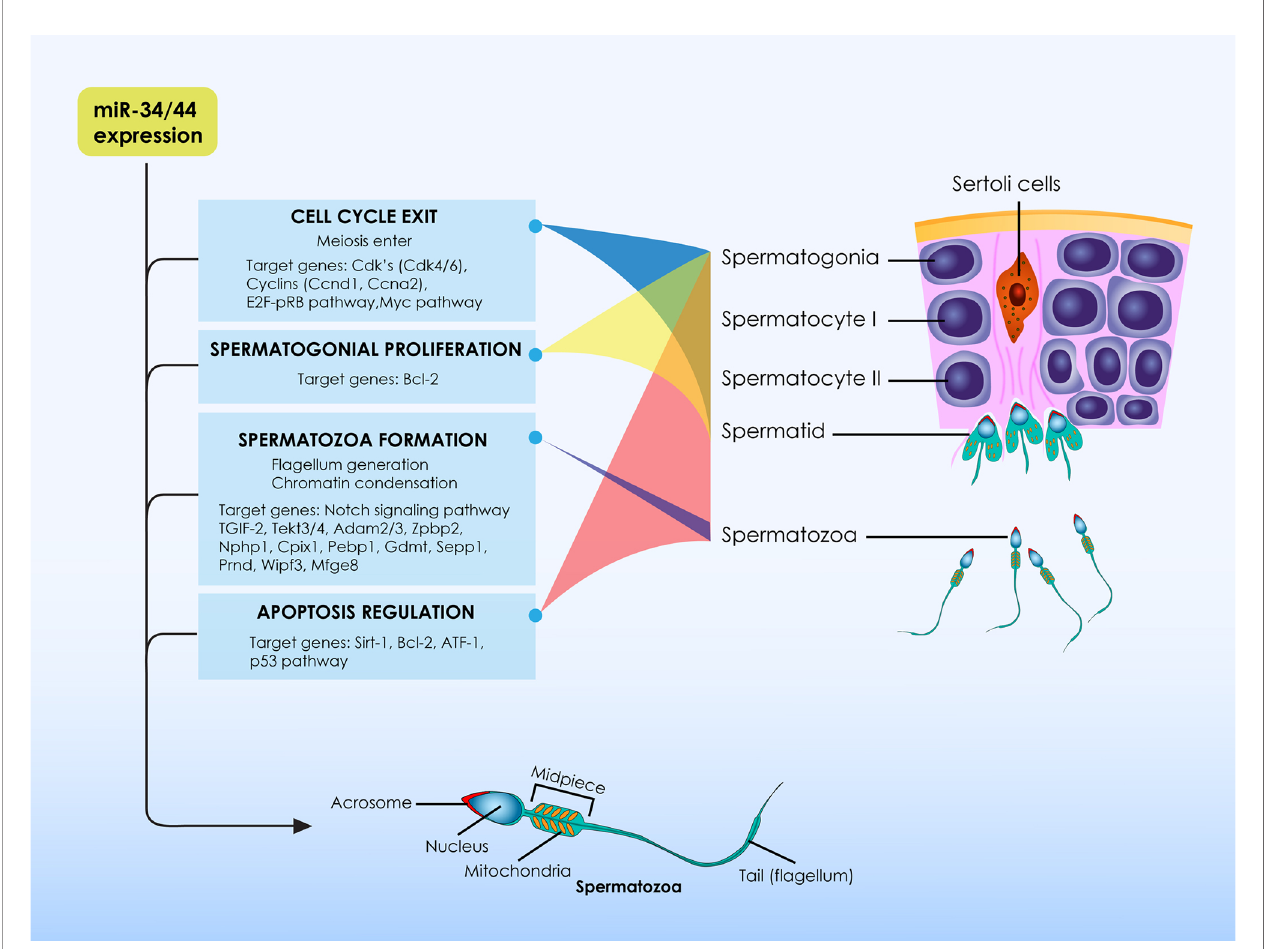
FIGURE 1 | The role of miR-34/449 family members on the physiological events entailed during spermatogenesis. At the initial stages of spermatogenesis miR-34/ 449 family members target several transcripts of cell-cycle regulatory proteins, leading germ cells to exit the cell cycle in order for spermatogenesis to be initiated. They are considered to be meiotic speci fi c microRNAs as their expression is relatively higher at the initiation of meiotic divisions. During spermatogenesis these microRNAs are essential molecules promoting normal spermatozoa formation via the differential regulation of expression levels of several spermatogenesis-related proteins depending on spermatogenesis stages. In addition, miR-34/449 family members do not only exert signi fi cant actions for the regulation of spermatogenesis, but also these molecules are essential for proper formation as well as for proper function of spermatozoa per se. Except from spermatogenesis, evidence also suggest that members of the miR-34/449 family exert signi fi cant anti-oxidant and anti-apoptotic properties and thus stand as signi fi cant elements of the testicular homeostatic